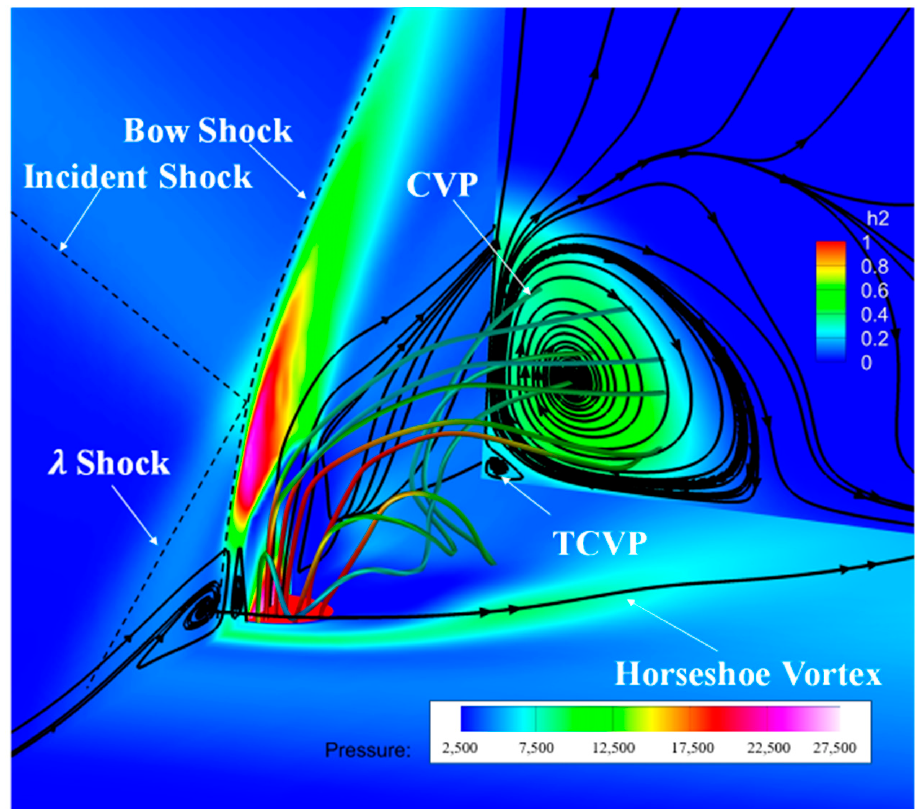
Figure 9. Flow field structure near fuel injection on the lower wall of Case3. In Case4, the SWG is set symmetrically to induce shock waves to intersect in front of the fuel jet, generating waves. Figure 10a,b show the Mach number contour and hydrogen mass fraction contour of the axial plane (Z = 0) of Case4. In Figure 10c, streamlines are colored with velocity in the x direction, and the movement in the flow direction is shown. The wall surface is colored with temperature. The progress of unfolding and downfolding of inflow is shown due to induced shock wave, as well as the acceleration and deceleration of inflow due to shock wave and expansion wave action.